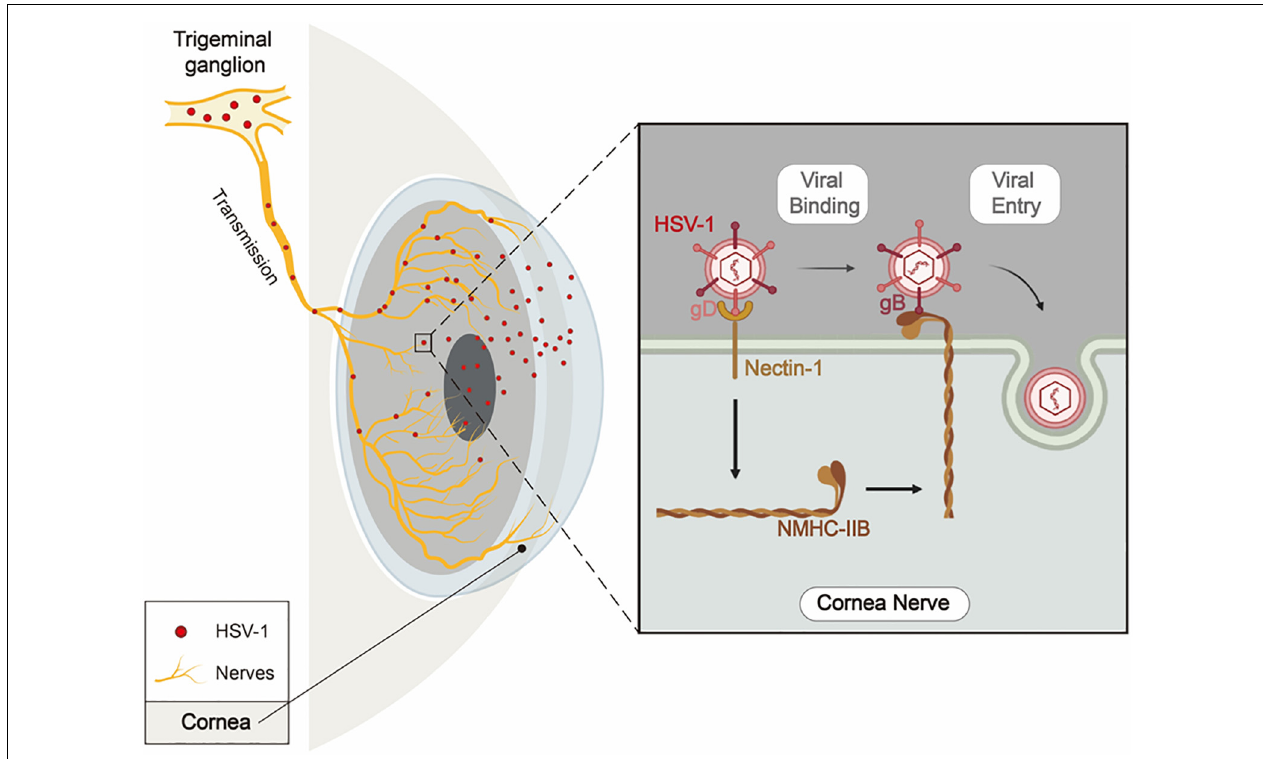
FIGURE 8 | Schematic diagram of nectin-1 and NMHC-IIB mediating HSV-1 entry into corneal nerves. When infecting the cornea, HSV-1 enters corneal nerves, travels along TG’s ophthalmic branches, and finally establishes latency in TG. During the entry of HSV-1 into corneal nerves, HSV-1 gD binds to nectin-1 as the first step. This results in the attachment of the virus to the cell surface and the upregulated expression of NMHC-IIB on the cell surface. Then, HSV-1 gB binds to NMHC-IIB, allowing the virus to fuse with the cell and thus completes its entry